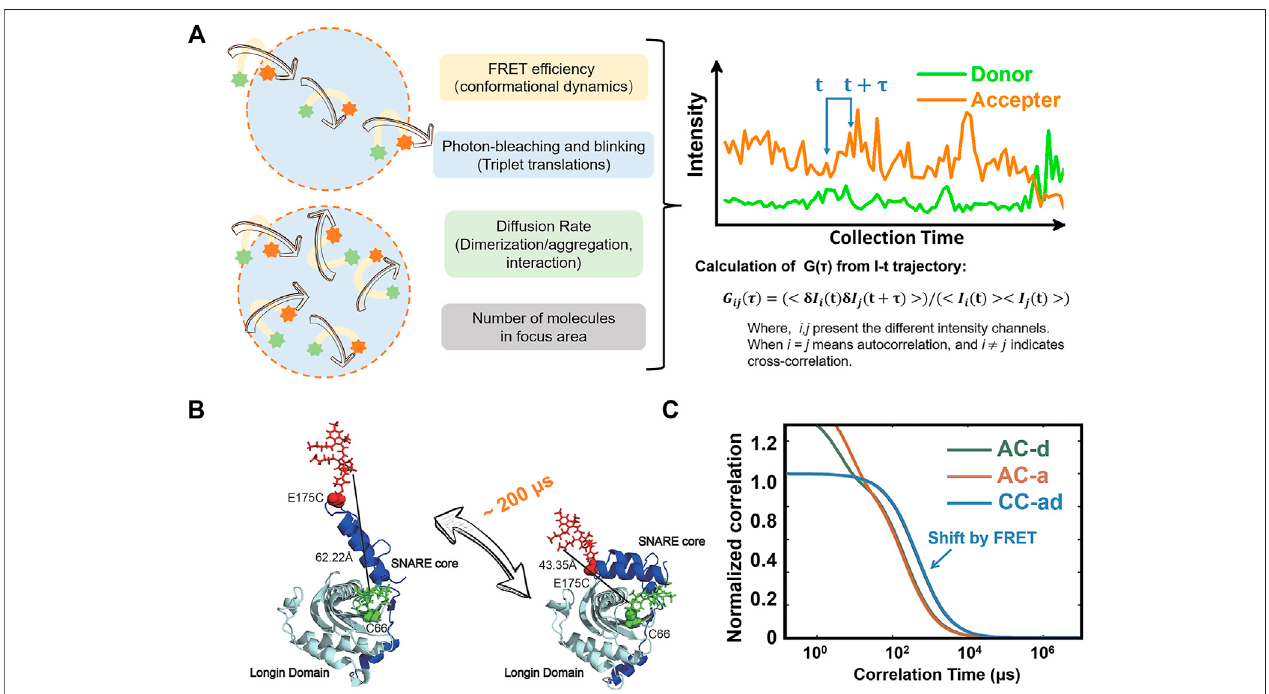
FIGURE 4 | Sub-millisecond dynamics disclosed by smFRET-FCCS method. (A) Principle of FRET-FCCS [75, 76]. The time-dependent fl uorescent intensity trajectories will fl uctuate due to the labeled molecules diffusing in and out of the focus (light blue area in orange circle), the change of molecule numbers in focus area, photobleaching, blinking of fl uorophores, and dynamics of proteins. Every course mentioned here can be described by a relevant model. (B) Experiment design of smFRET detection on Ykt6. (C) Auto- and cross- correlation traces in smFRET-FCCS experiment. The shift between auto- and cross- correlation traces denote that the conformational changes occurred during the diffussion through the focus areas. (AC-d: auto correlation trace of donor channel; AC-a: auto correlation trace of acceptor channel; CC-ad: cross- correlation trace of acceptor and donor channels). Panel (B,C) are adapted from Ref. [73].